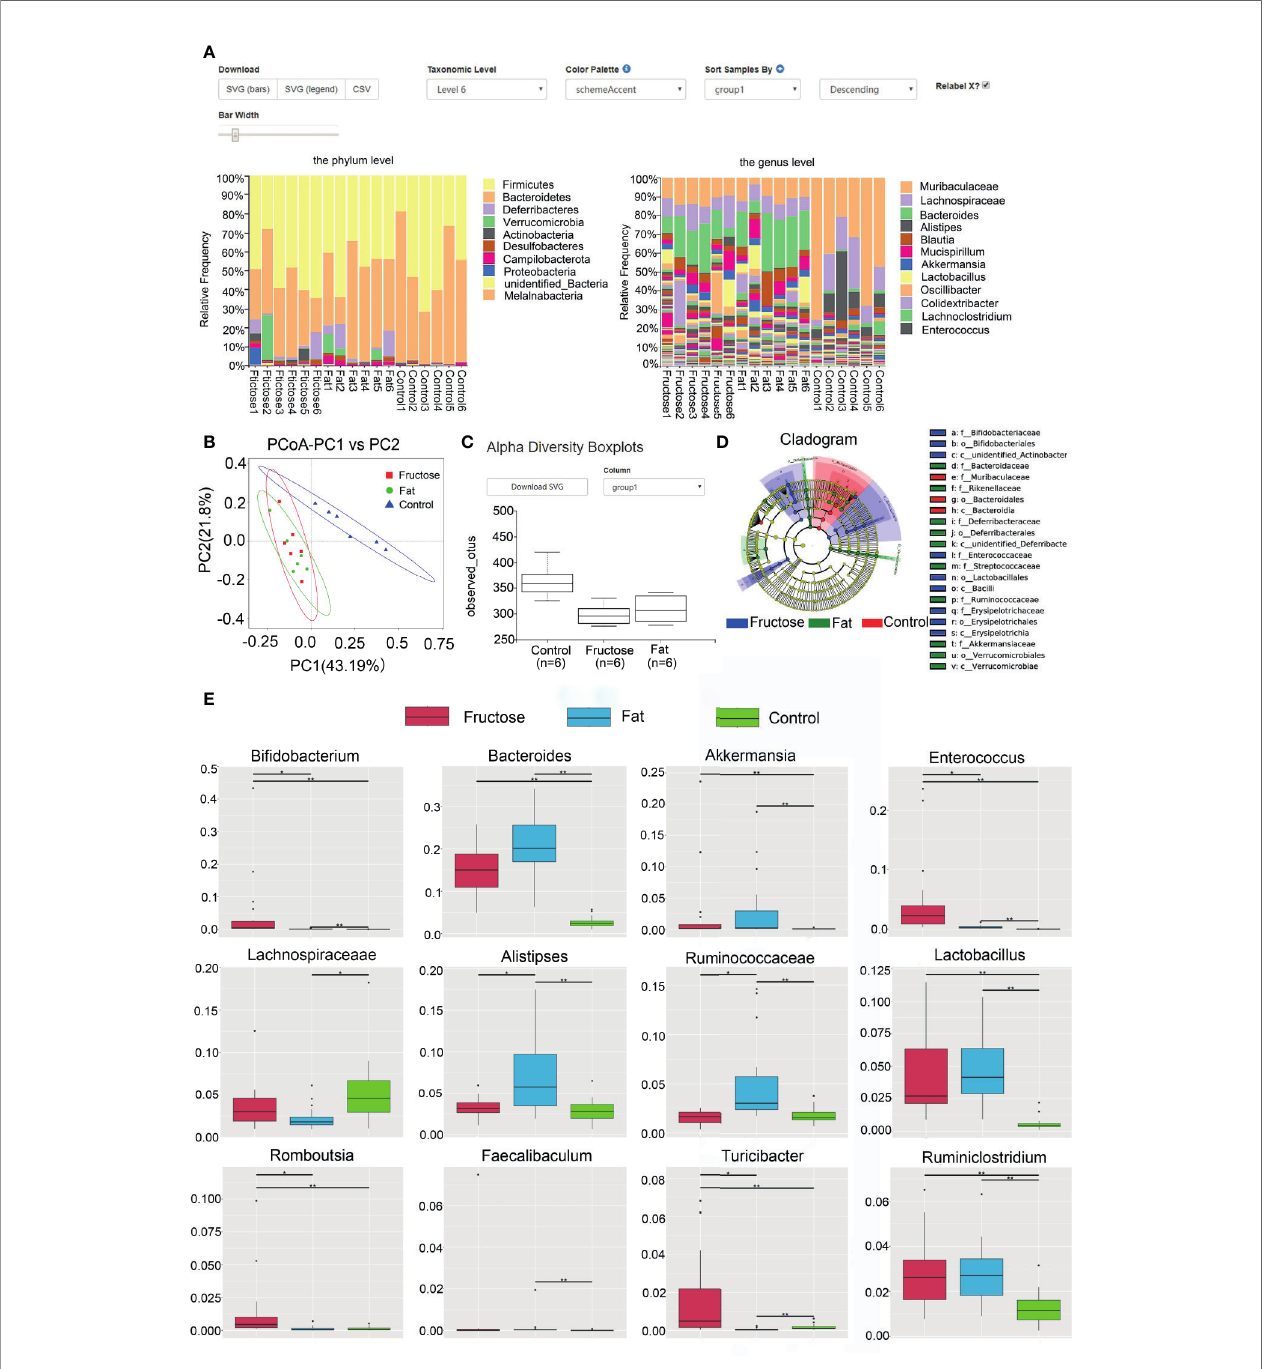
FIGURE 3 | High-fructose and high-fat diets changes the intestinal microbiota in mice. The relative abundance of the top 10 microbes at the phyla level and genus level in each group is shown in the histogram, with the horizontal axis being the sample name and the vertical axis being the relative abundance (A) . In the PCoA analysis, the abscissa represents one principal component, the ordinate represents another principal component, and the percentage represents the contribution value of principal component to the sample difference (B) . Alpha diversity box chart: Observed species is the observed number of species (also known as the OTU number) (C) . An evolutionary branching diagram in which the circles radiating from the inside to the outside represent the taxonomic level from phylum to genus (or species) (D) . The abundance distribution box diagram of different species between groups, in which the horizontal axis is the sample grouping and the vertical axis is the relative abundance of the corresponding species (E) . (* p < 0.05, **p <